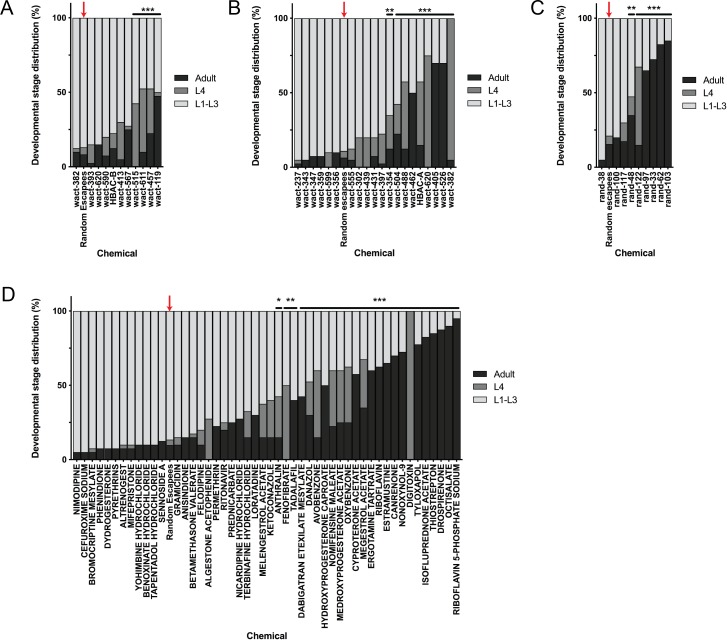
Post-hoc statistical analysis showing that 142 chemicals out of the 278 chemicals identified from the primary screen produced developmental stage distributions that were significantly different from random escapee wells (red arrows).It is important to note that this was performed with the assumption that 20 worms were in each well as a means of estimating the proportion of actual L4 and adult counts in each well. In other words, we assumed #L1-L3 larvae = 20 – (#L4 + #adult). Plots shown are from independent screens of (A) 7.5 μM wactives, (B) 60 μM wactives, (C) 60 μM ‘random’ non-wactives, and (D) 60 μM US Drug Collection. Statistical analysis by Kruskal-Wallis test with Dunn’s multiple comparisons post-test where *p<0.05, **p<0.01, ***p<0.001.